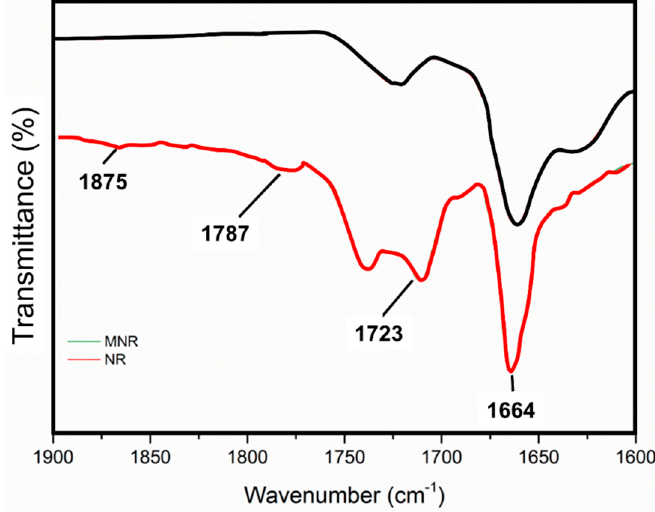
Figure 2. FTIR spectra in wavenumber range 1900–1600 cm − 1 of NR and MNR at 8 phr of MA. Table 2. The observed peaks and their assignments for MNR samples.